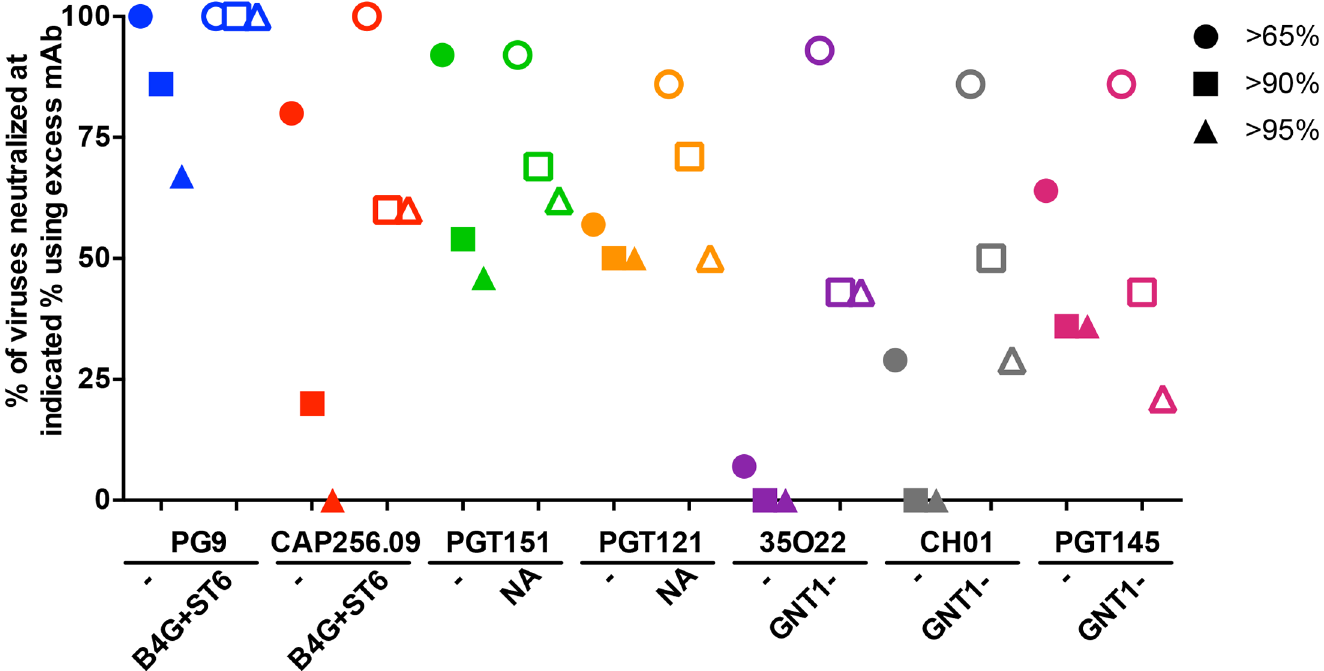
Fig 6. GE improves neutralization saturation. For each mAb, the number of the 14 viruses from Fig 5 that were neutralized above 65%, 90% or 95% in the presence of 10 μ g/ml of the mAb indicated were expressed as a percentage of the total viruses. Open symbols represent the optimal glycomodification for each nAb; B4GALT1 +ST6GAL1 (abbreviated as B4G+ST6) for PG9 and CAP256.09, NA treatment for PGT151 and PGT121, and GNT1- cells for 35O22, CH01 and PGT145. This analysis included data only for those strains that were neutralized in either the control or modified condition (or both) with IC50s < 1 μ